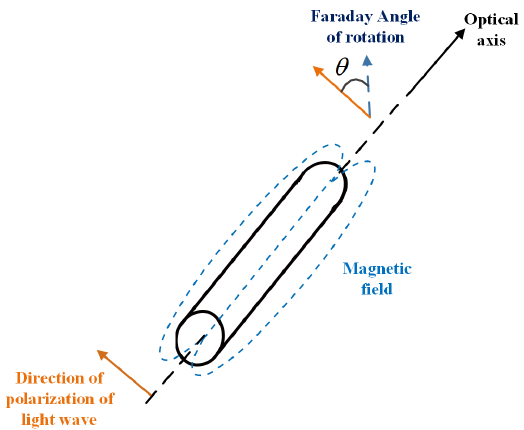
Figure 1. The change of polarization direction by magneto-optical Faraday effect. The Verdet constant of the polarization maintaining fiber (PMF) used in the fiber op- tic gyroscope is 6.4 × 10 − 4 rad/(m·mT). The magneto-optical Faraday rotation angle is pro-